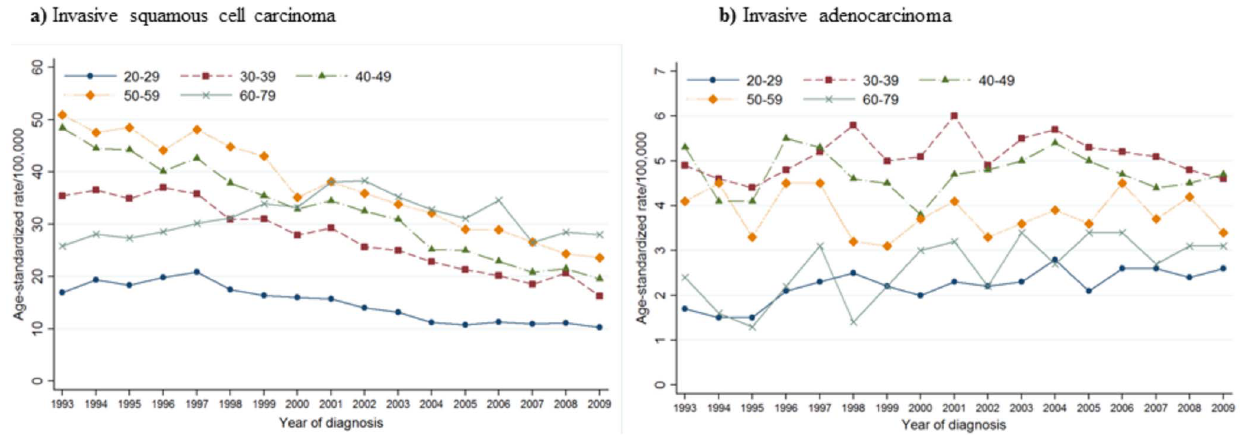
Figure 3. Trends in age standardized incidence rate for invasive squamous cell carcinoma and adenocarcinoma according to the age group in Korea, 1993–2009.